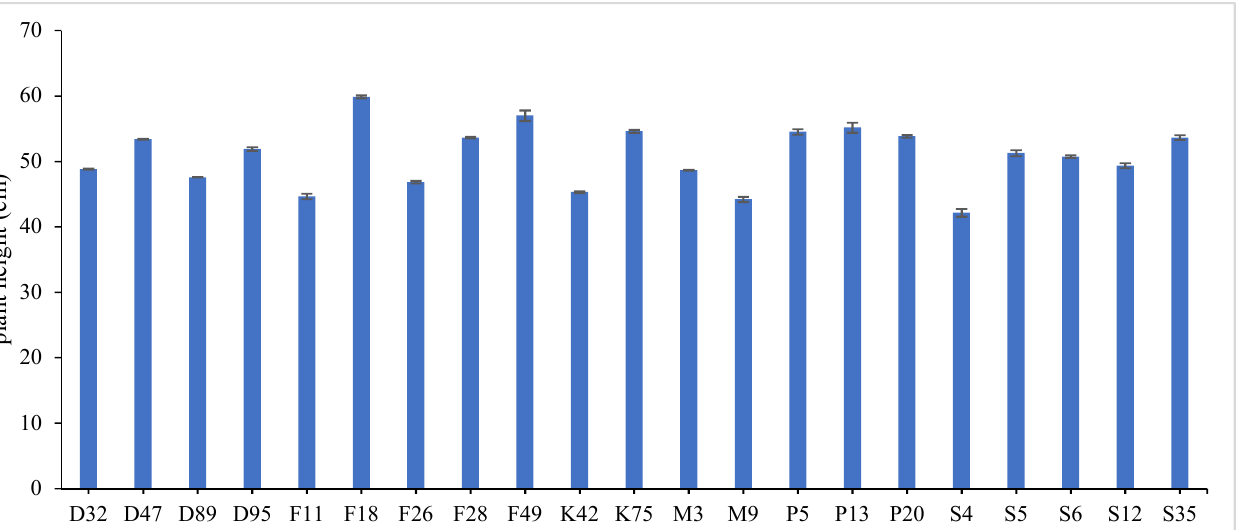
Figure 2. Mean performance of number of tiller/m 2 of twenty-one alfalfa genotypes at combined across the two years. Bar represents the standard deviation.